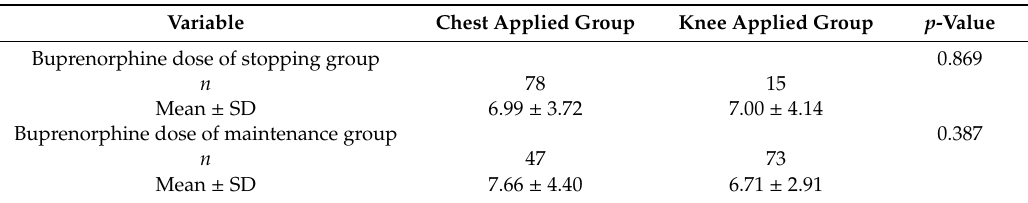
Table 5. Comparison of the buprenorphine doses administered between the chest applied group and knee applied